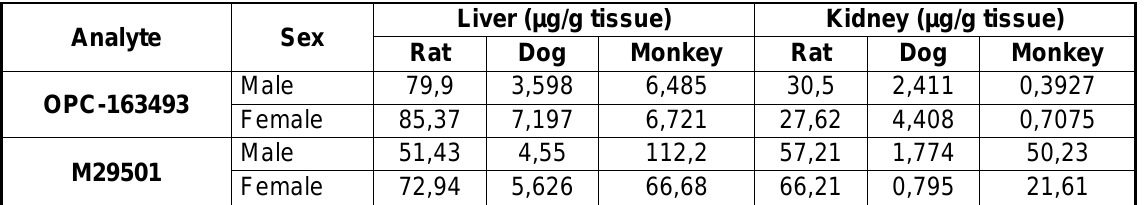
Table 5: The average concentrations of OPC-163493 and M29501 in the tissues